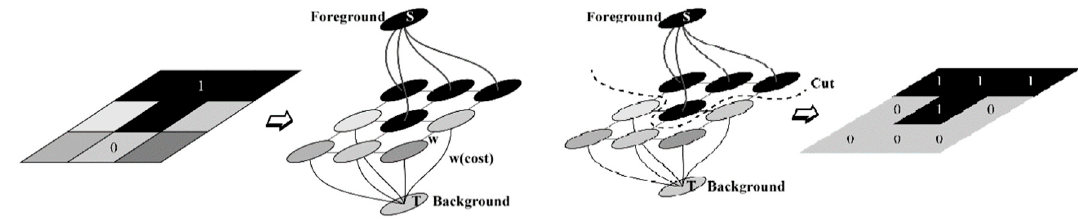
Figure 10. A demonstration of a minimum cut operation in image segmentation [69].